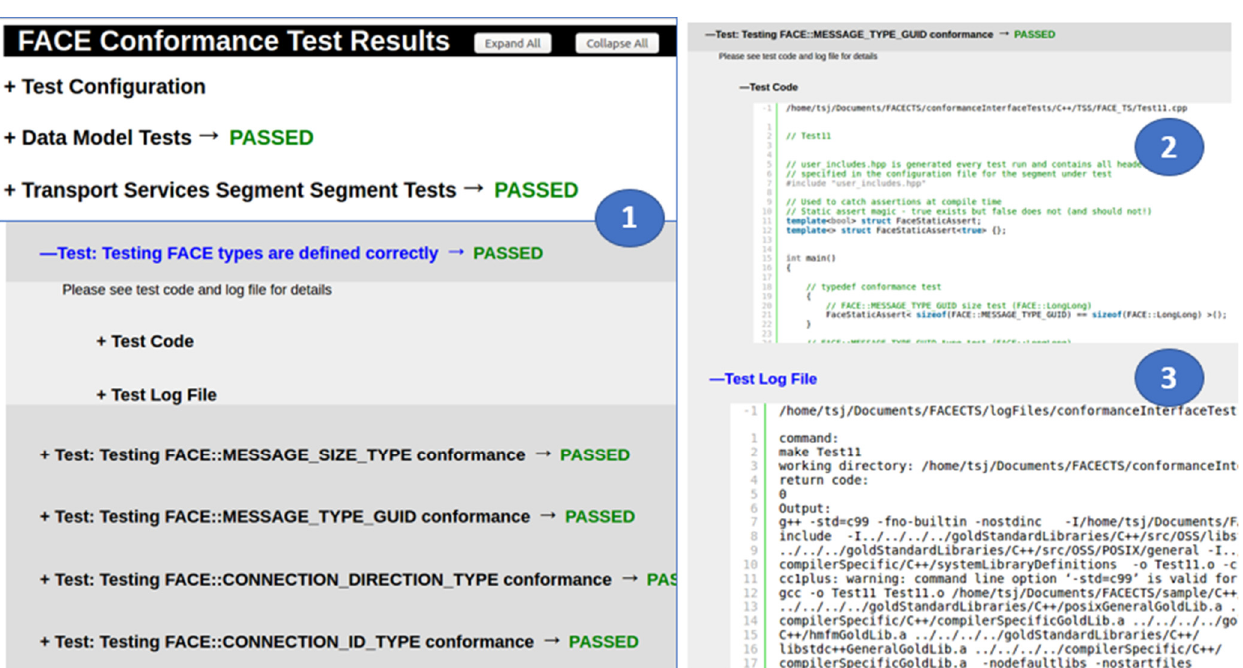
Figure 12. The test result of CTS is shown in the web browser. (1) results of the FACE CTS, (2) the code used for the test, and (3) test log file generated in performing the test.